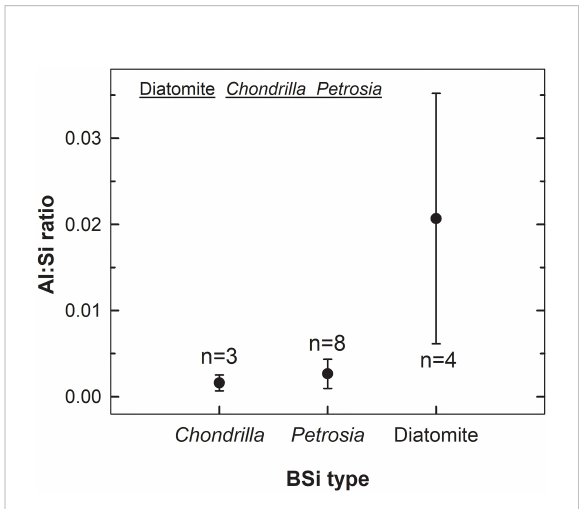
FIGURE 7 Comparison of Al : Si ratios in the BSi of the spicules of the sponges Chondrilla caribensis and Petrosia fi ciformis , and Miocenic diatomaceous earth. A Kruskal-Wallis one-way ANOVA on ranks found signi fi cant between-group differences (H= 8.823, P = 0.012). The “ a posteriori ” Dunn ’ s test revealed that the ratio in the diatomaceous earth is signi fi cantly larger than that in the spicules of the two sponges ( P = 0.022, P = 0.036), which were not signi fi cantly different from each other ( P > 0.50), as graphically indicated in the upper zone of the graph (i.e., BSi types with Al : Si ratios not signi fi cantly different are underlined by the same line). See extended statistics in Supplementary Results S2. “ n ” refers to the number of replicates analyzed, which varied depending on sample availability.